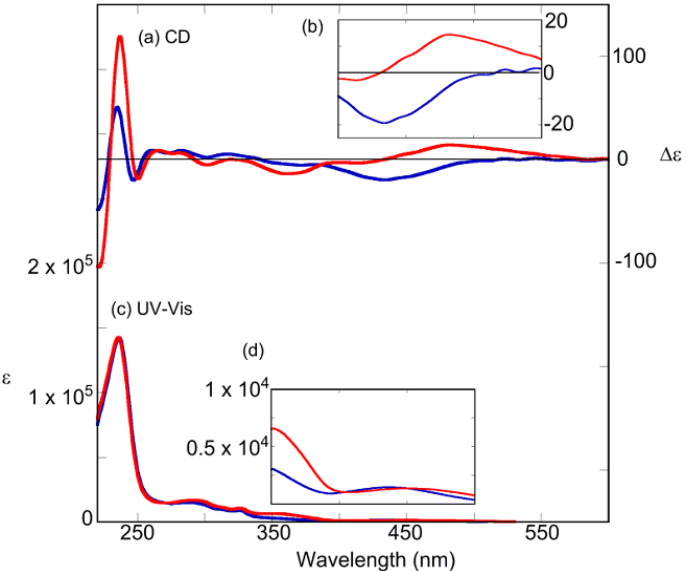
Figure 4. (a, b) CD spectra of ( R )- 2 . (c, d) Absorption spectra of ( R )- 2 . After 365-nm irradiation (blue line), after 436-nm irradiation (red line). Conditions: 1,4-dioxane (1.0 × 10 − 5 M), 20 °C, light path length = 10 mm, irradiation wavelength = 365 nm